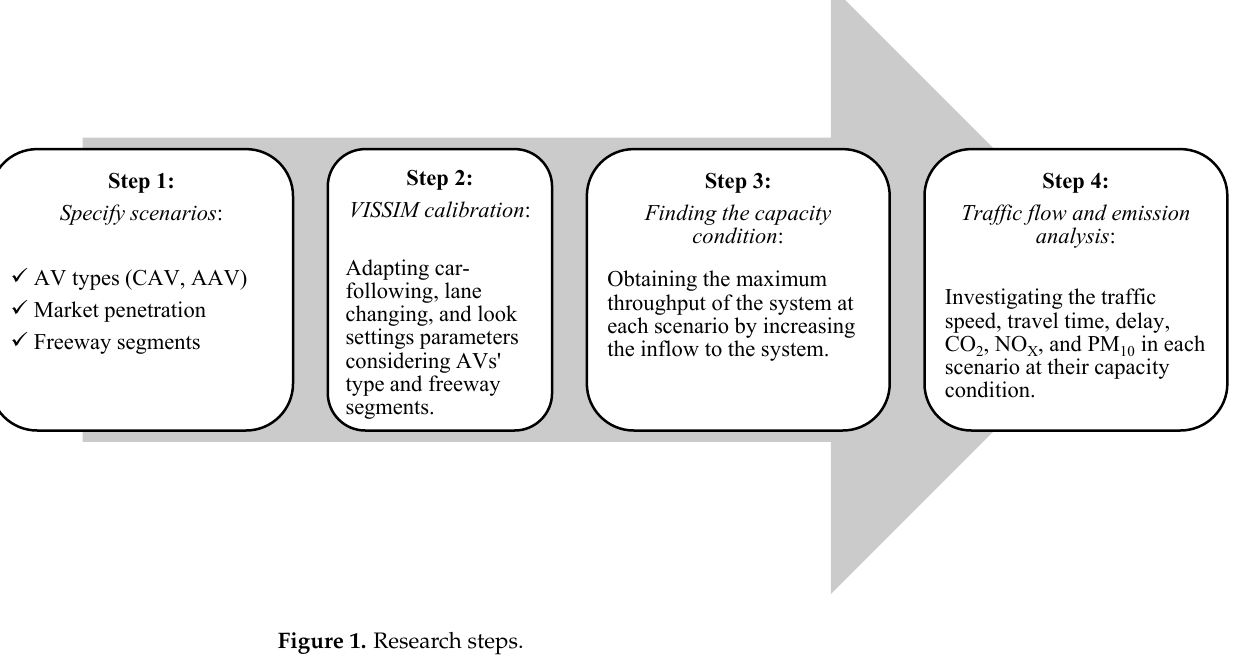
Figure 1. Research steps.